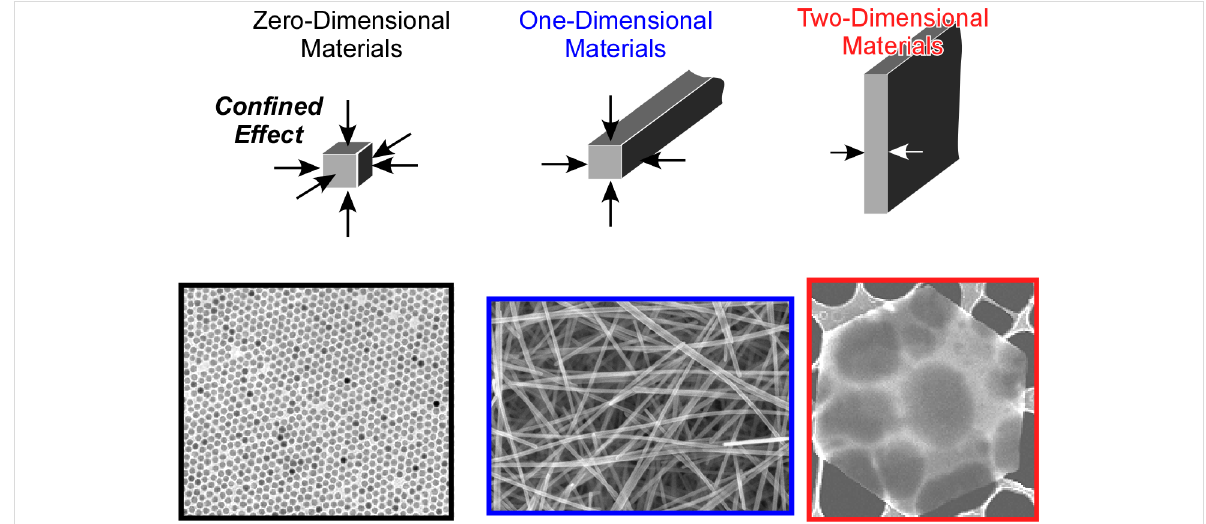
Figure 1: Various low-dimensional materials (zero-dimensional, one-dimensional, and two-dimensional materials) with morphology